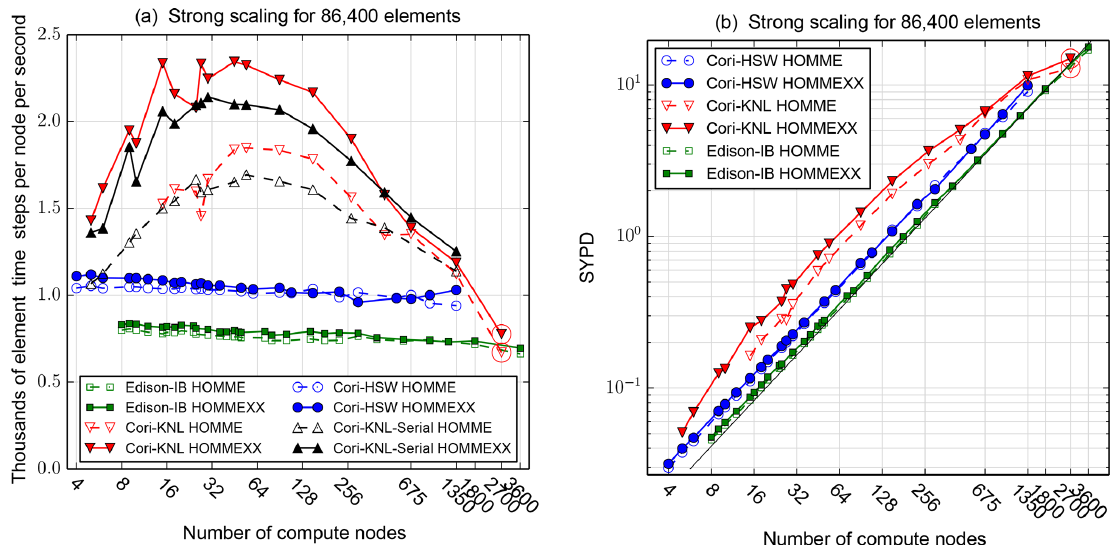
Figure 9. Strong scaling at large scale on NERSC platforms for grid generated with n e = 120 (0 . 25 ◦ resolution). (a) The number, in thou- sands, of elements that can be integrated one total time step (as shown in Fig. 4), per node, per second, is plotted as a function of the number of nodes. Each of the 86400 elements represents the work for the fourth-order spectral element extruded in 3-D for 72 vertical levels, as shown in Fig. 1b, for dynamics and also the advection of 40 tracers. Higher values indicate better performance. A horizontal line represents ideal strong scaling. Red circles indicate that threads are used within an element. (b) The same data are plotted in terms of simulated years per wall-clock day of compute time (SYPD). The solid black line represents ideal strong scaling.